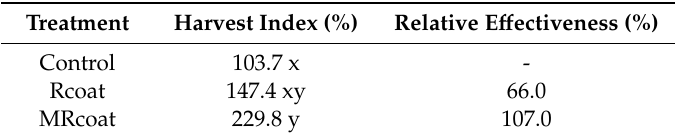
Table 2. Harvest index (ratio of grain dry weight to shoot dry weight) of chickpea and relative effectiveness of inoculation (ratio of shoot dry weight of inoculated plant to shoot dry weight of non-inoculated plants) under field conditions.